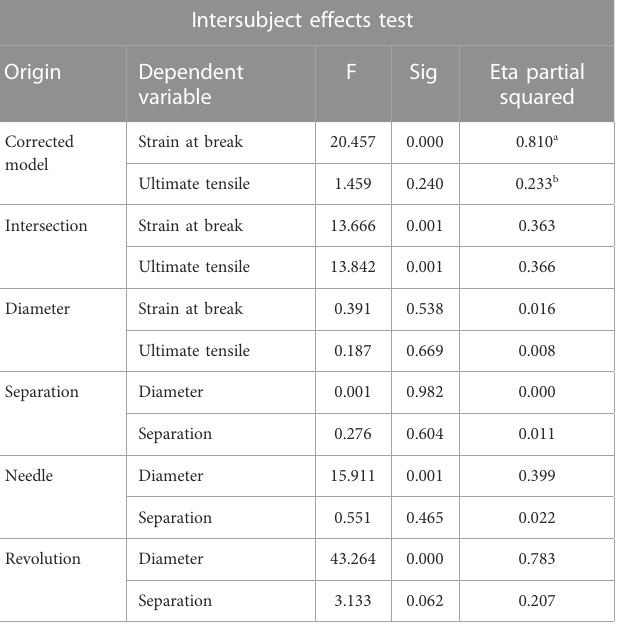
TABLE 5 MANCOVA for strain at break and ultimate tensile